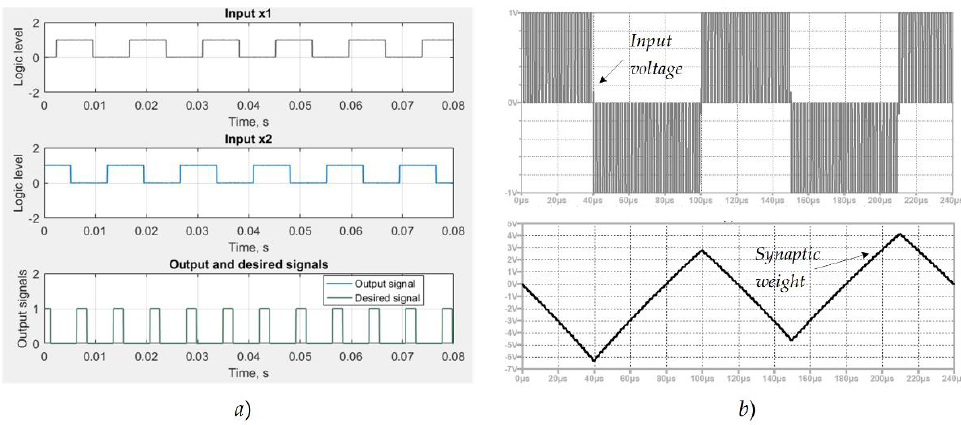
Figure 9. ( a ) Time diagrams of the input and output signals of the memristor neural network; ( b ) Diagrams of the input signal of the synaptic circuit and the corresponding alteration of the weight.